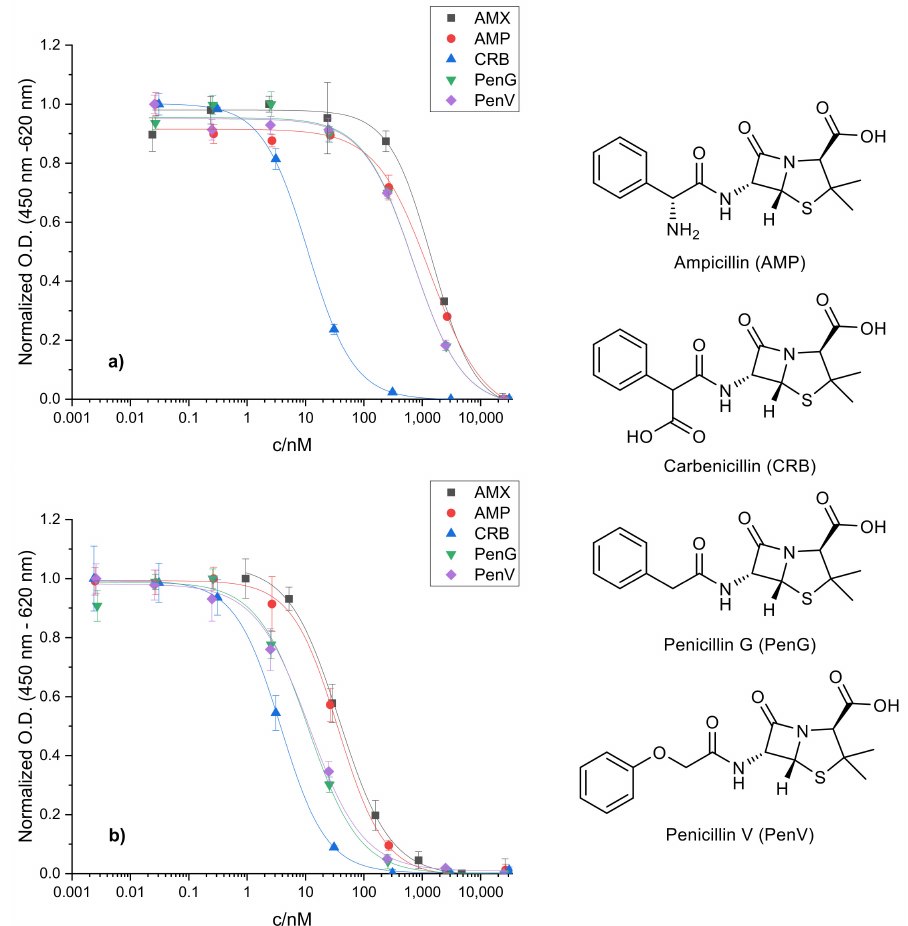
Figure 4. ( a ) ELISA calibration curves of structurally similar β -lactams before, and ( b ) after hy- drolysis, and their structures (right). IC 50 values (before; after hydrolysis): AMP (1350 ± 130 nM; 36.2 ± 3.7 nM), CRB (11.0 ± 0.4 nM; 3.8 ± 0.5 nM), PenG (700 ± 70 nM; 11.1 ± 1.7 nM), and PenV (702 ± 66 nM; 11.6 ± 2.5